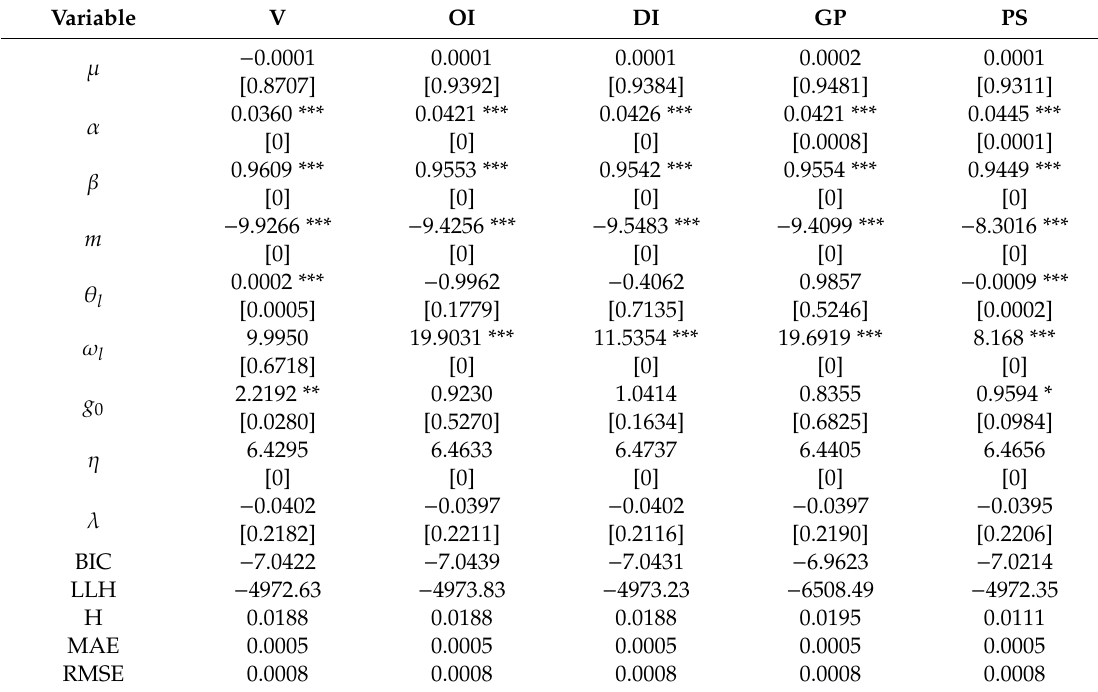
Table 4. Estimation results of high-frequency and single-factor level e ff